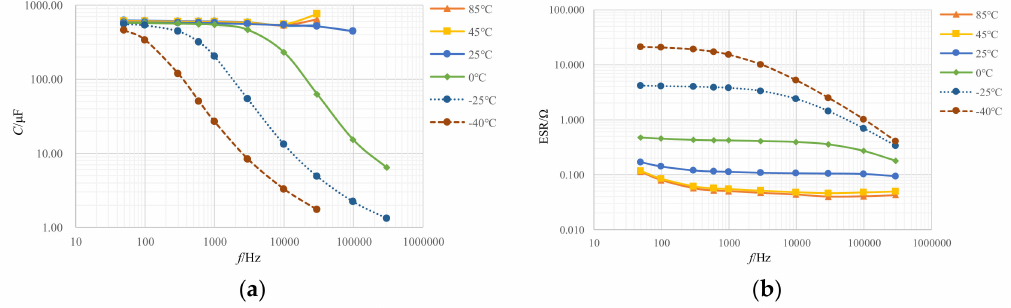
Figure 1. The frequency characteristic curves of capacitance (C) and equivalent series resistance (ESR)